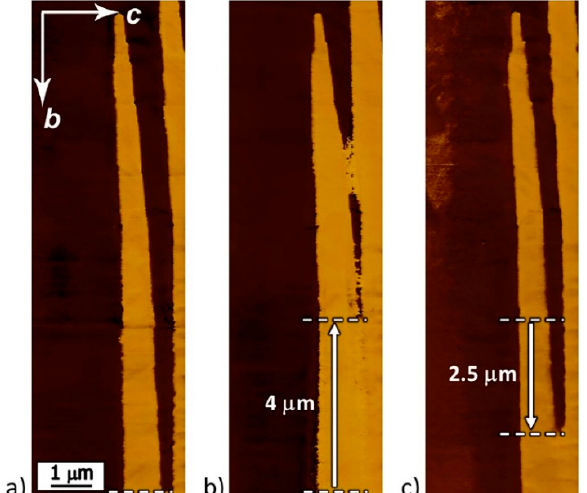
Figure 6. PFM images of domain evolution under the action of the pyroelectric field: ( a ) As-grown structure; ( b ) after heating from 10 °C to 35 °C with a heating rate of 120 °C/min, and ( c ) after cooling from 35 °C to 10 °C with cooling rate of 10 °C/min. Lateral PFM contrast. Arrows b and c show the directions of crystal axis.